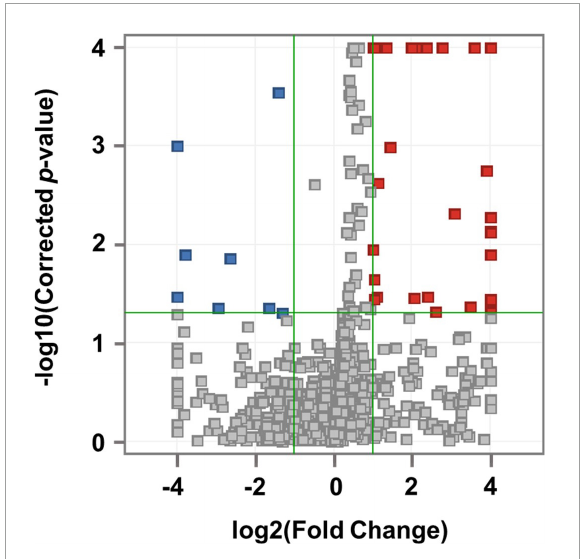
FIGURE2 Volcano plot analysis. Compared to the control group, 53 MFs that increased in MDD are indicated by red squares and 8 MFs that decreased in MDD are indicated by blue squares. The horizontal green line represents the corrected p -value = 1.3 with the negative common logarithm applied, and the vertical green lines represent the standard value of fold change more than twice with the 2 logarithm (up-fold change = 1 and down-fold change =